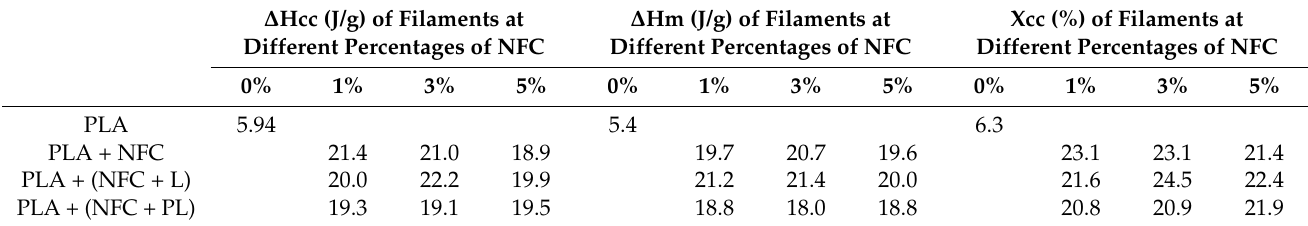
Table 9. Enthalpy of cold crystallization, enthalpy of melting, and degree of crystallinity by DSC analysis. ∆ Hcc (J/g) of Filaments